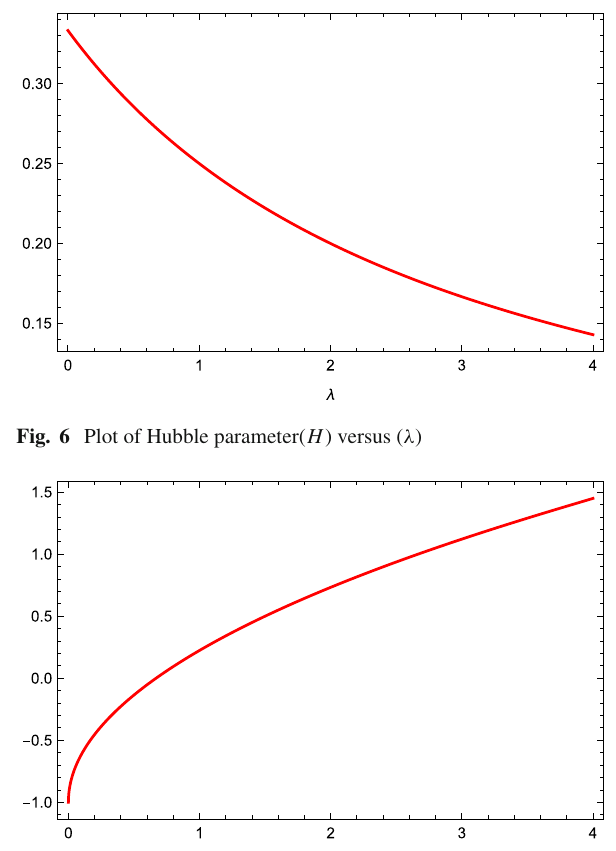
Fig. 7 Plot of deceleration parameter( q ) versus ( λ )